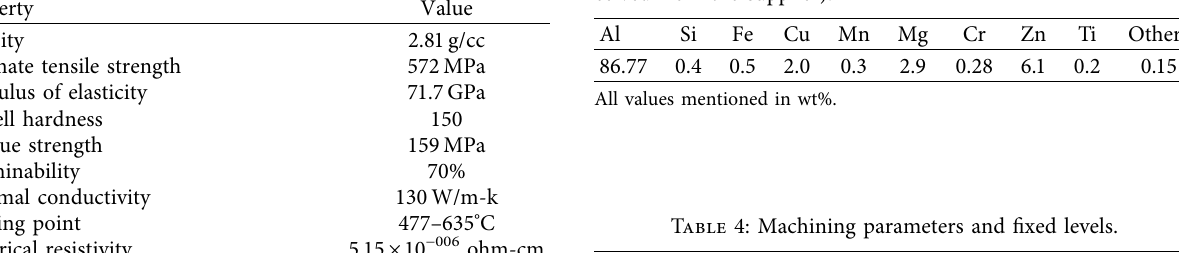
Table 2: Mechanical properties of aluminum 7075 alloy. Table 3: Chemical composition of aluminum 7075 alloy (as re- ceived from the supplier).